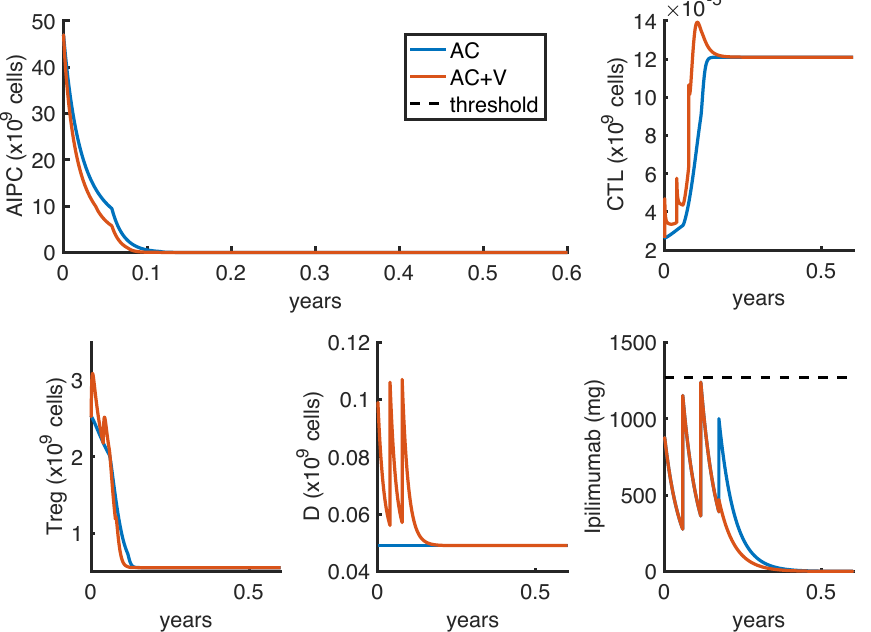
Figure 6. Administration protocol with the aim of tumor eradication as result of the optimization problem OP2, with ∆ t = 3 weeks. Blue lines represent the model dynamics in case of ipilimumab mono-therapy (AC), while orange lines represent the one in case of ipilimumab and sipuleucel-T combination therapy (AC+V). The ipilimumab threshold has been highlighted with a black dotted line.